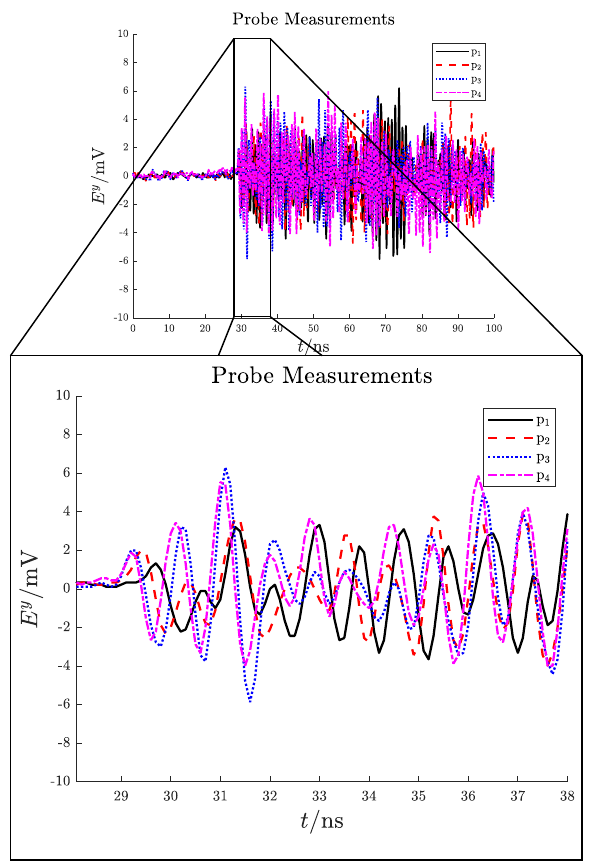
Figure 18. Test case 2. Electric field signals detected by the antennas in mV.